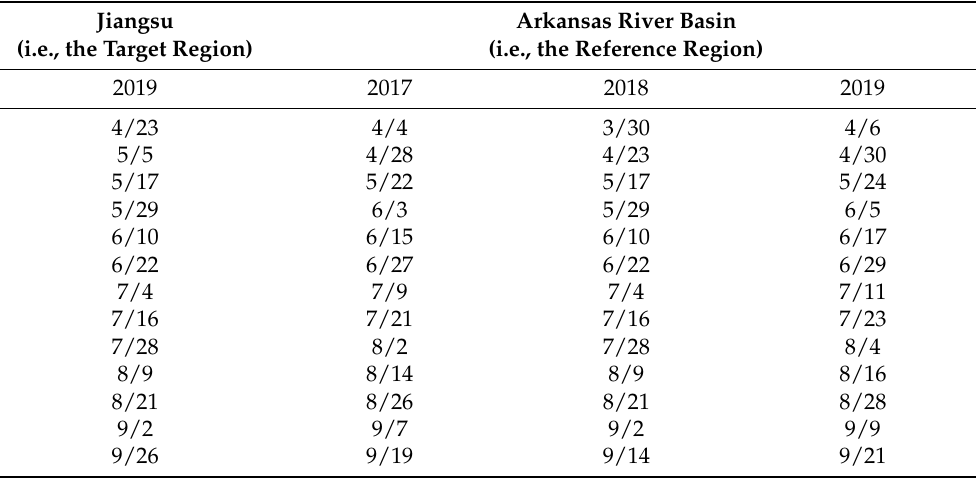
Table 1. Data acquisition dates